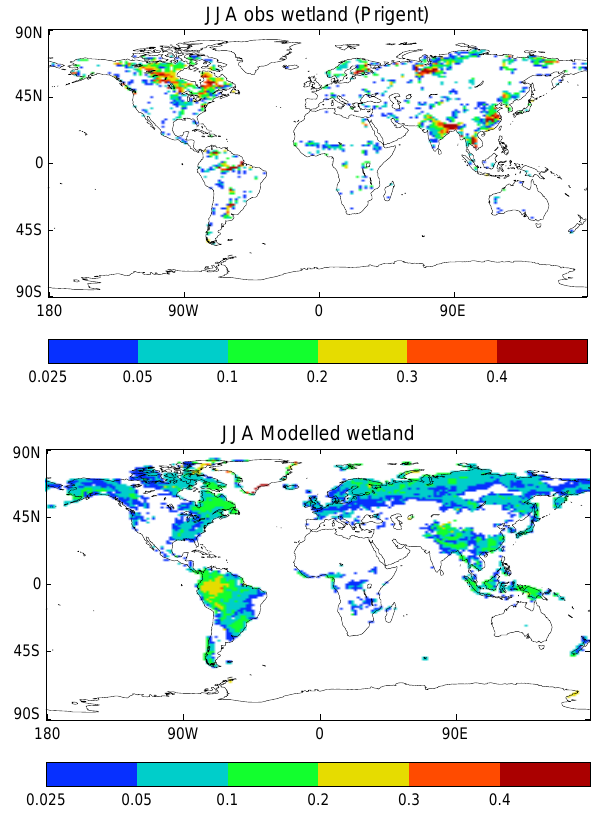
Fig. 6. June-July-August average inundation fraction: (a) satellite observations (Prigent et al., 2001, b ) HadGEM2